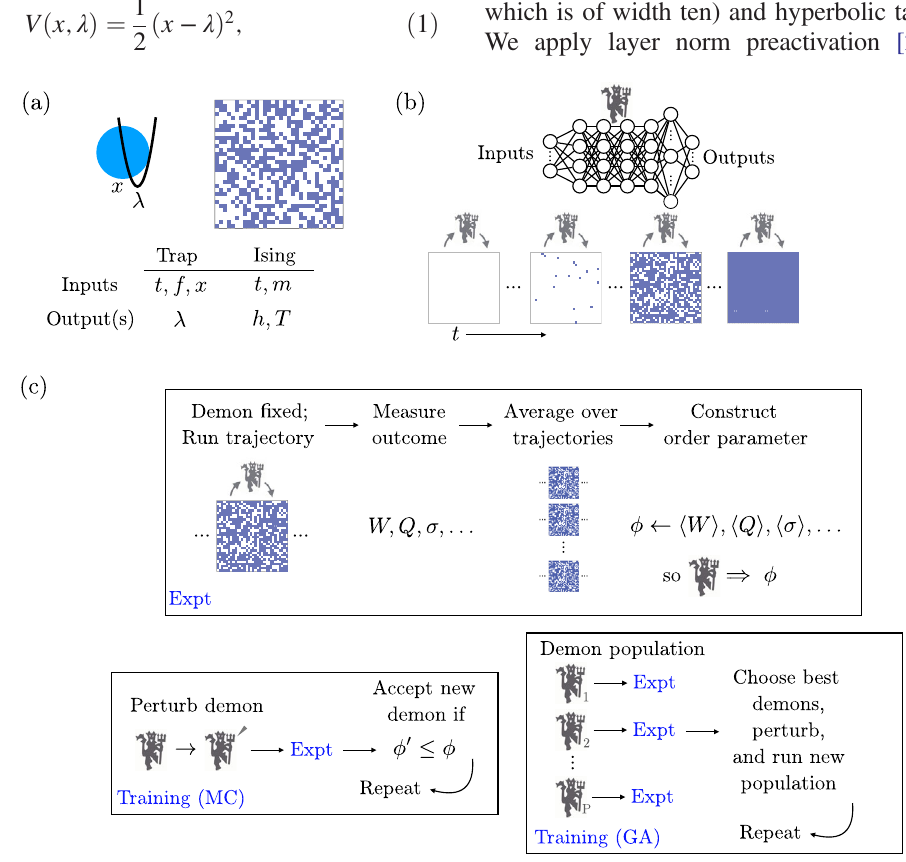
FIG. 1. (a) We develop feedback-control protocols for an overdamped particle pulled by a harmonic potential and the Ising model undergoing magnetization reversal. (b) Feedback is enacted by a demon, a deep neural network, which controls the protocol to which the system is subjected by periodically taking in information from the system and outputting new values of the system ’ s control parameters. (c) The demon is trained to extremize a desired physical observable, such as heat or work. Dynamical trajectories of the system, generated using the demon-mandated protocol, result in an order parameter ϕ that is composed of ensemble averages of work, heat, entropy production, or other measurable quantities (box labeled “ expt ” ). The demon is trained iteratively, by Monte Carlo (box “ MC ” ) or genetic algorithms (box “ GA ” ), to extremize ϕ . In this paper, the trajectories are generated by computer simulations of model systems, but the same learning procedure could be applied to trajectories generated in laboratory